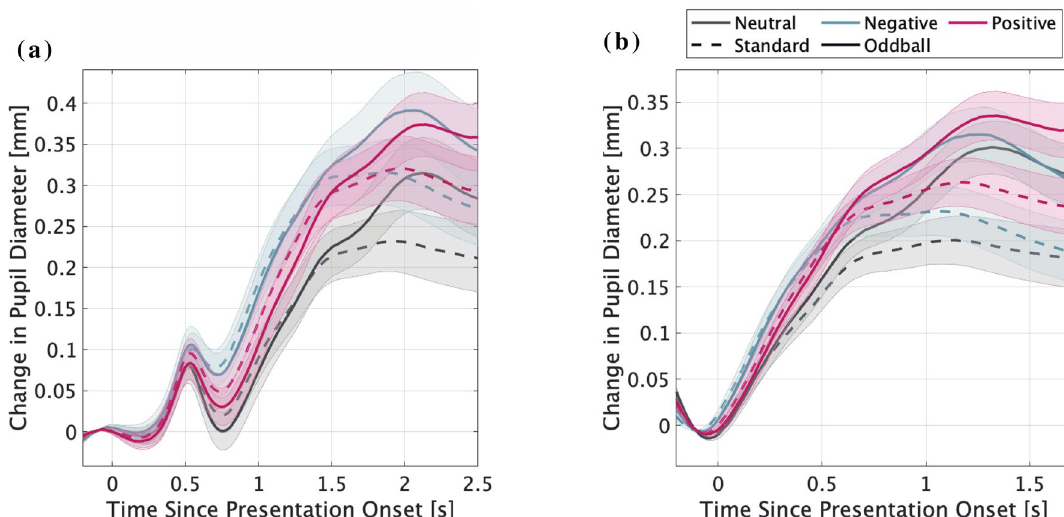
Figure 2. The grand-averaged time course of pupillary responses to the beep sounds (standard and oddball) in each picture category. ( a ) Pupillary responses using picture presentation onset as a baseline. ( b ) Pupillary responses using beep sound presentation onset as a baseline. The horizontal axis indicates the time (s), while the vertical axis indicates the grand-averaged change in pupil dilation from baseline (− 200 ms to 0 ms). Shaded areas represent the standard error of the